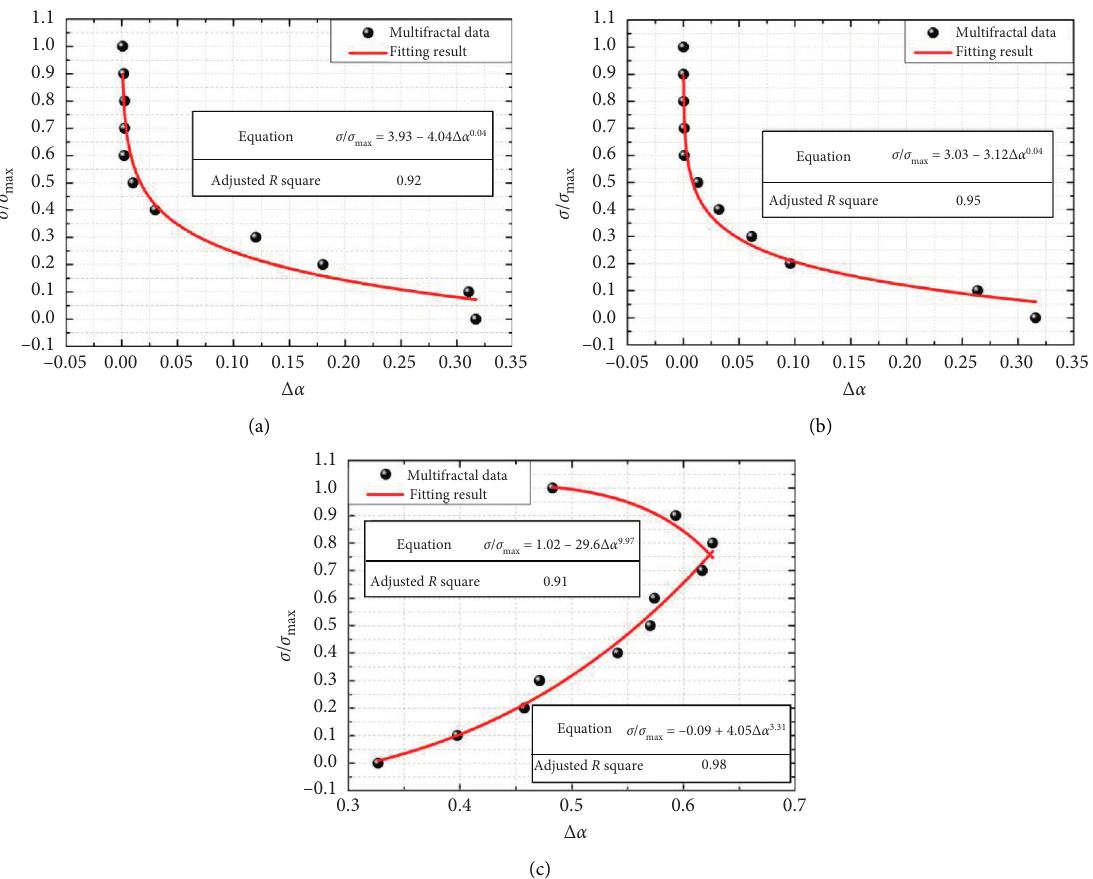
Figure 6: The fitting relationship between multifractal parameter Δ α and stress. (a) X direction. (b) Y direction. (c) Z direction.